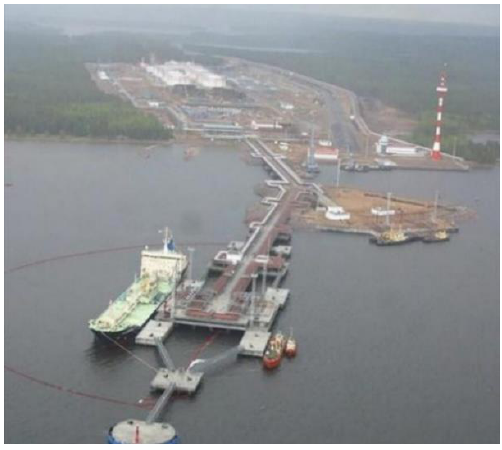
Figure 12. Port of Visotsk. Source: [84].